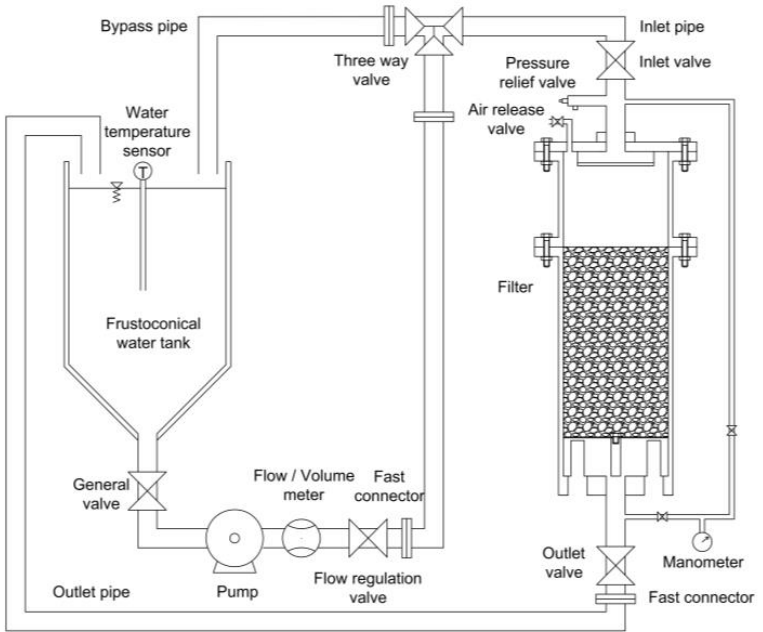
Figure 2. Experimental laboratory setup.